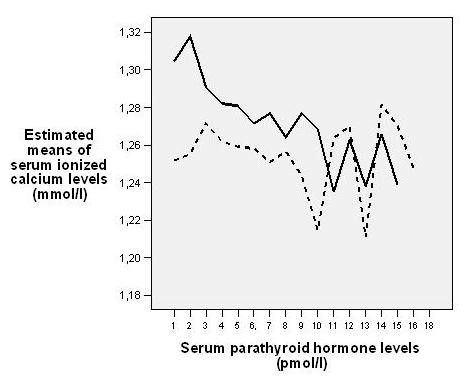
Age- and gender-adjusted estimated marginal means of s-Ca2+ at different s-iPTH in Pakistanis (n = 161) (—) and Norwegians (n = 560) (- - -). Note that there are few observations (n = 46) at serum parathyroid hormone levels above 9 pmol/l.